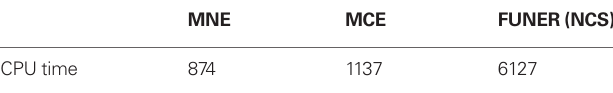
Table 4 | execution time in